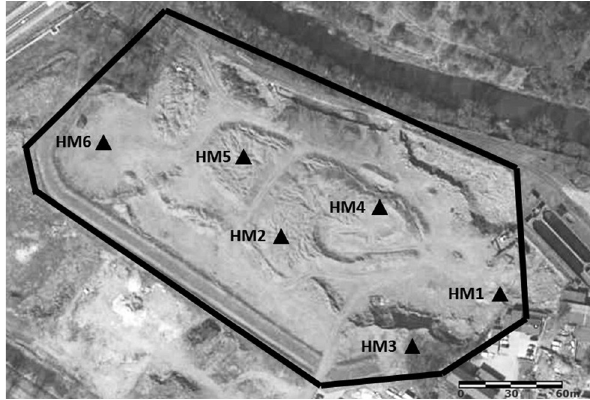
Figure 2: Location of the land fi ll and waste sampling sites. Source: www.google.pl/maps